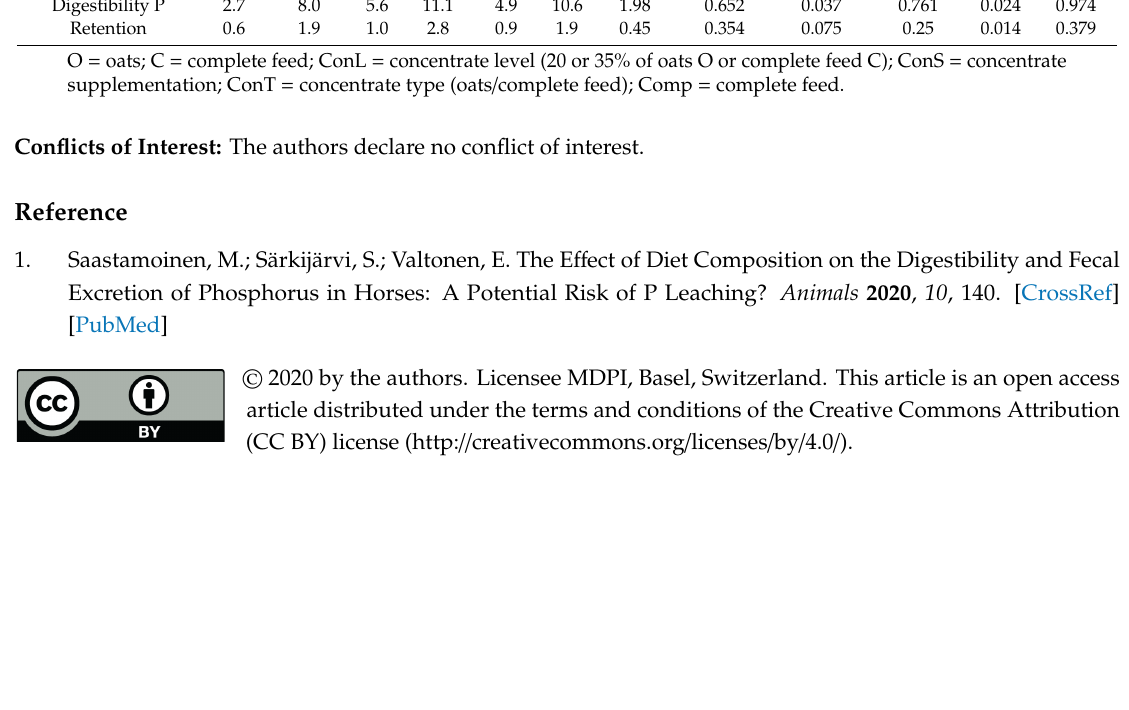
Statistical Significance ( p -Values) Pooled Haylage Hay SEM vs. Others